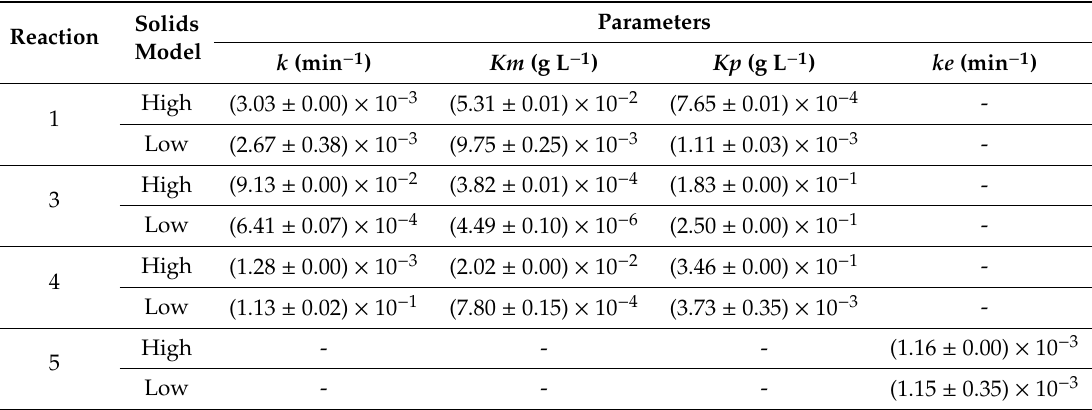
Table 2. High and low models parameters—parameter ± standard